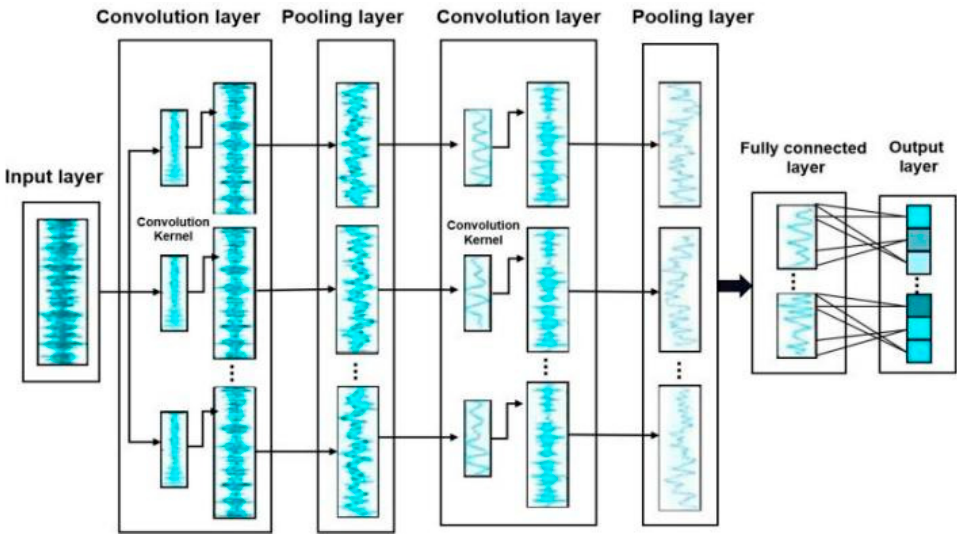
Figure 1. The 1DCNN